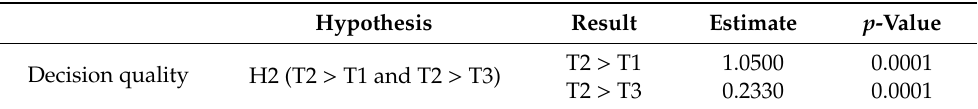
Table 2. Participants’ decision quality